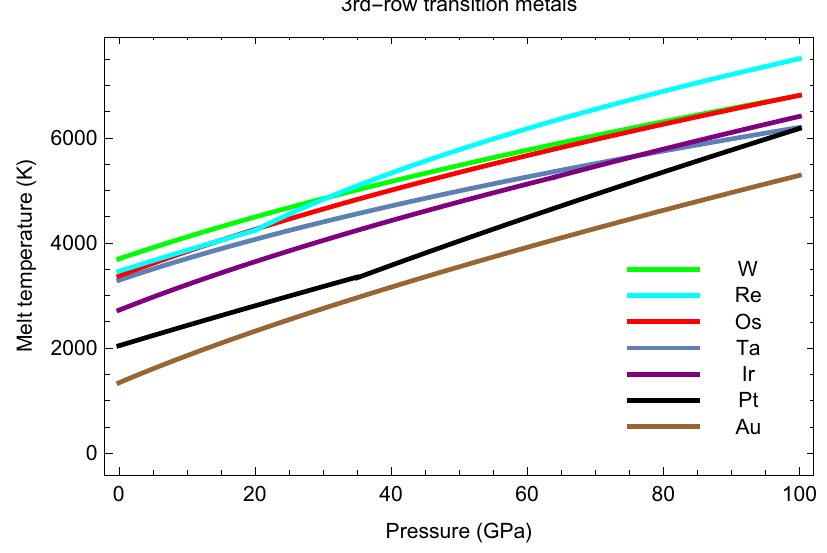
Figure 16. The melting systematics of the 3rd-row transition metals based on the available experimental and/or theoretical